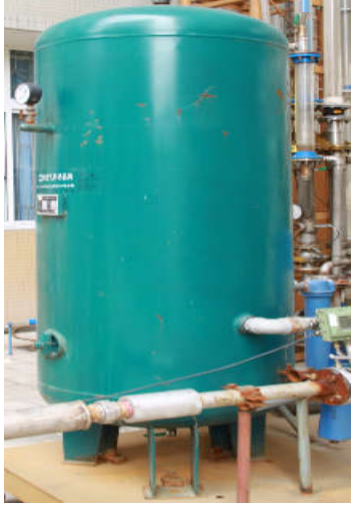
Figure 9. Gas storage tank.